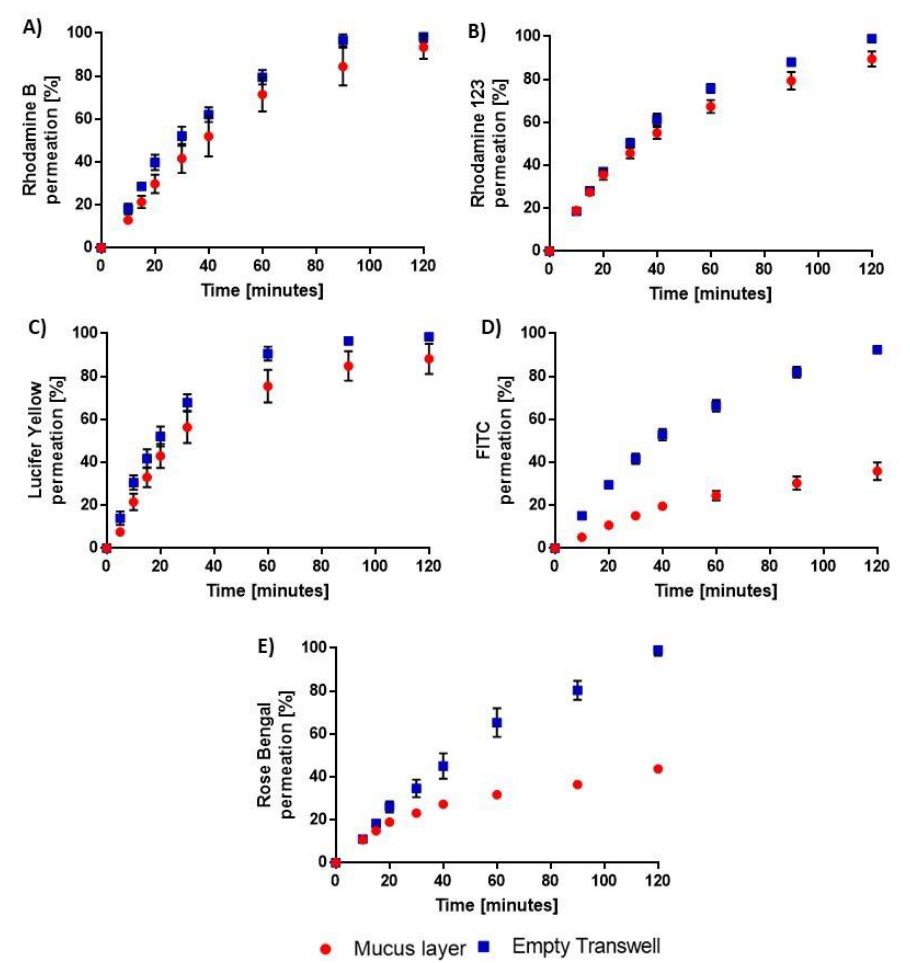
Figure 2. Permeation profiles of fluorescent dyes across mucus layers spread at the surface of 0.4 µm pore size polyester Transwell ® inserts and corresponding empty inserts. 50 µL of the dye solutions were added to the apical chambers at t = 0. A : Rhodamine B; B : Rhodamine 123; C : Lucifer yellow; D : FITC; E : Rose Bengal. Data are expressed as cumulative percentage of the initial donor dose recovered in the basolateral compartment as a function of time. They are presented as mean ± SD (n = 4) or mean ± SEM (FITC; N = 4, n = 4).